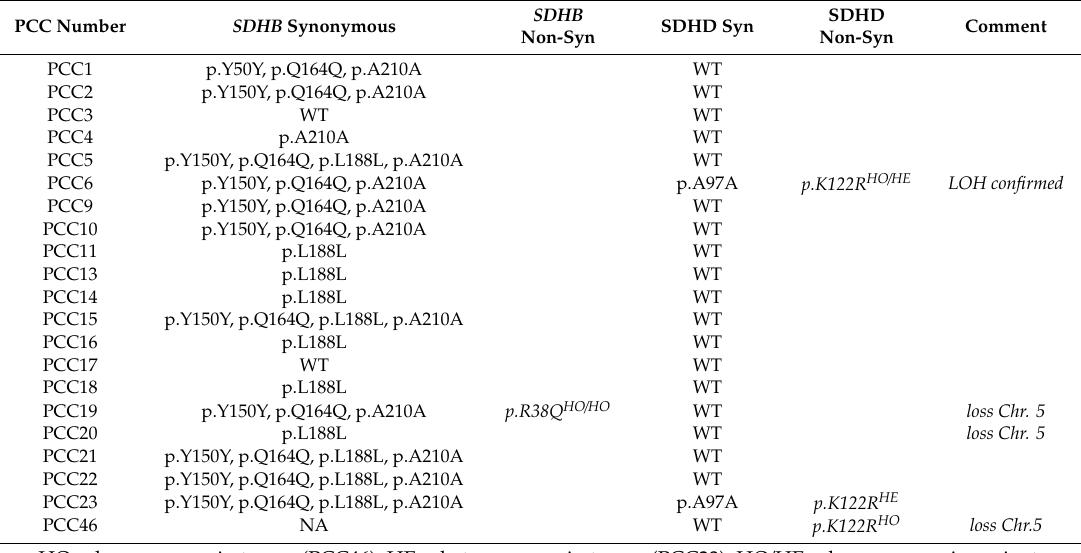
Figure 3. Homology between dog chromosome 5 and 26, and the human genome. It shows the homology between dog chromosome 5 and 26 and several human chromosomes. Of note is that the SDHD gene is located on dog chromosome 5 (see Supplemental Figure S2). Table 1. Variants identified by Sanger Sequencing. SDH-variants that were previously described by Holt et al. [10] as mutations are depicted in bold and italic. If a non-synonymous variation was detected in the tumor, the corresponding germline was investigated for the presence of the